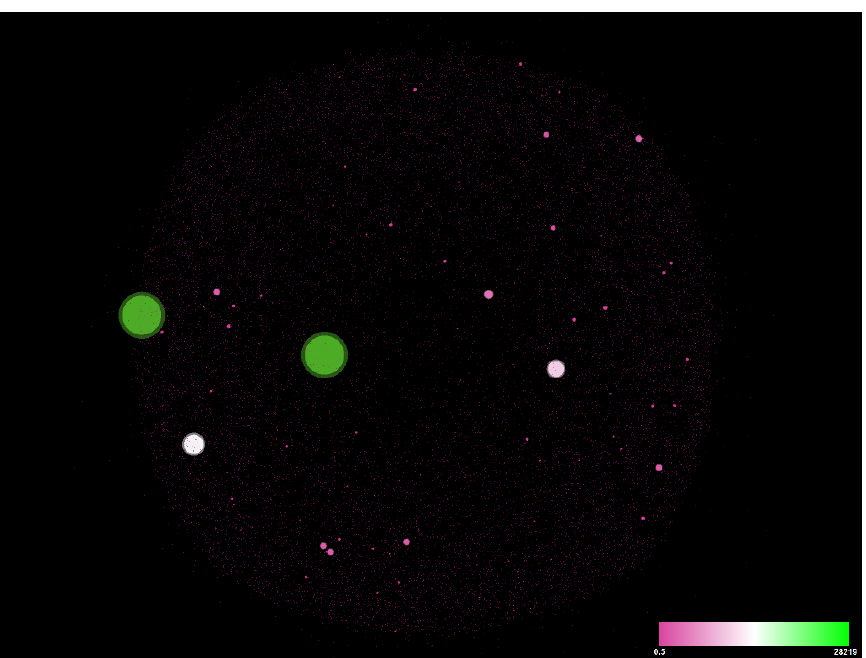
Figure 5. Congestion rate ( CR 1 i ) in the